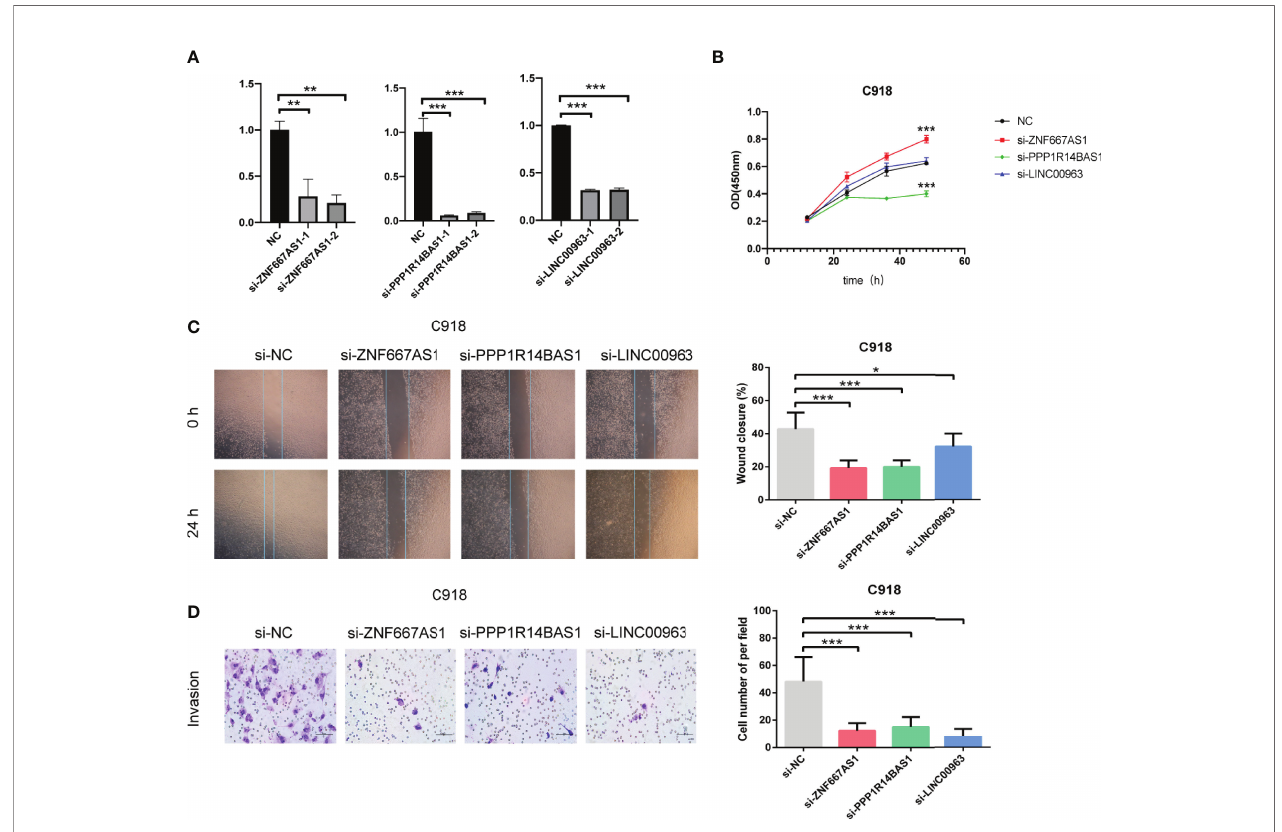
FIGURE 12 | Characteristics of FRLs signature and its functional effect on C918 cells. (A) The transfection ef fi ciency veri fi ed by qRT-PCR. (B) The viability of C918 detected through CCK-8 assay after knockdown of three identi fi ed FRLs. (C) Cell migration observed under the microscope. (D) The differences in the invasive ability of C918 cells. * p < 0.05, ** p < 0.01, and *** p < 0.001. “ ns ” means no signi fi